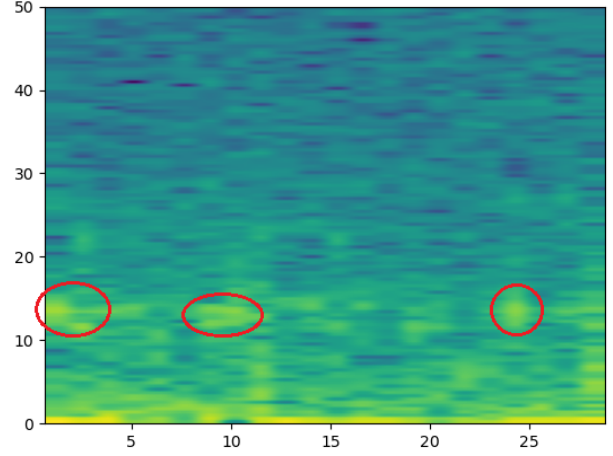
Figure 2. Spectrogram of N2.